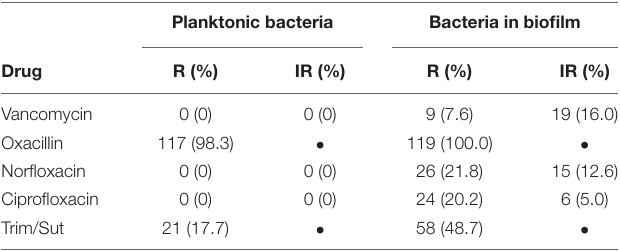
Planktonic bacteria Bacteria in